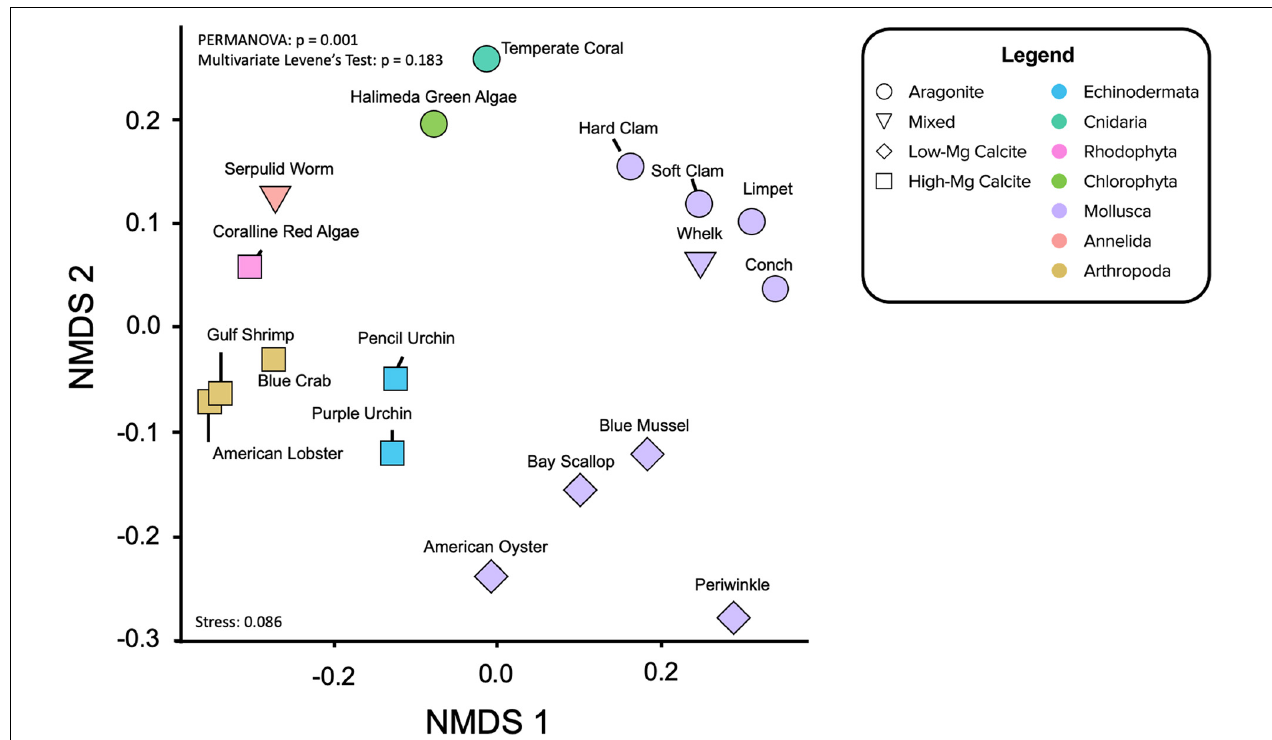
FIGURE 5 | Non-metric Multidimensional Scaling (NMDS) ordination of the elemental ratio data projected to two-dimensions and colored by taxon phylum. Shape denotes mineralogy. PERMANOVA determined whether clustering by phyla is significant ( p = 0.001). Multivariate Levene’s test of homogeneity ( p = 0.183) and the stress value for this analysis (0.086) are reported. Visualizing the elemental ratio data in this way further illustrates the relative influences of mineralogy and phylogeny and potentially provides a framework for interpreting diagenetic effects of fossil